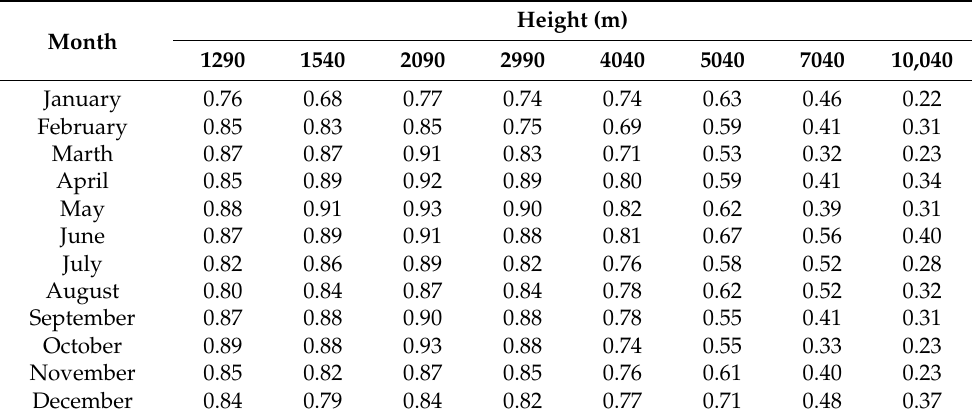
Table A3. Correlation coefficients between zenith wet delay and water vapor pressure of Kashi station at different heights and months.